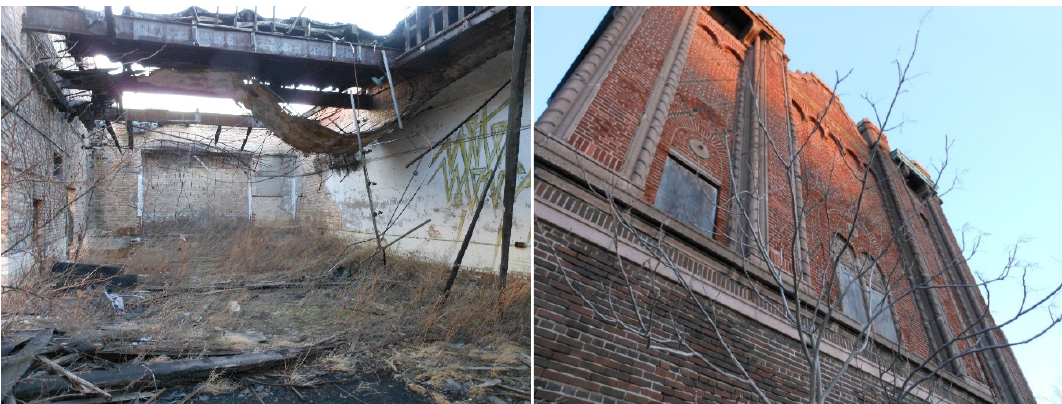
Figure 6. Remains of Gary Public Schools Memorial Auditorium, Gary, Indiana (Photos courtesy of Ball State University undergraduate architecture student Shannon